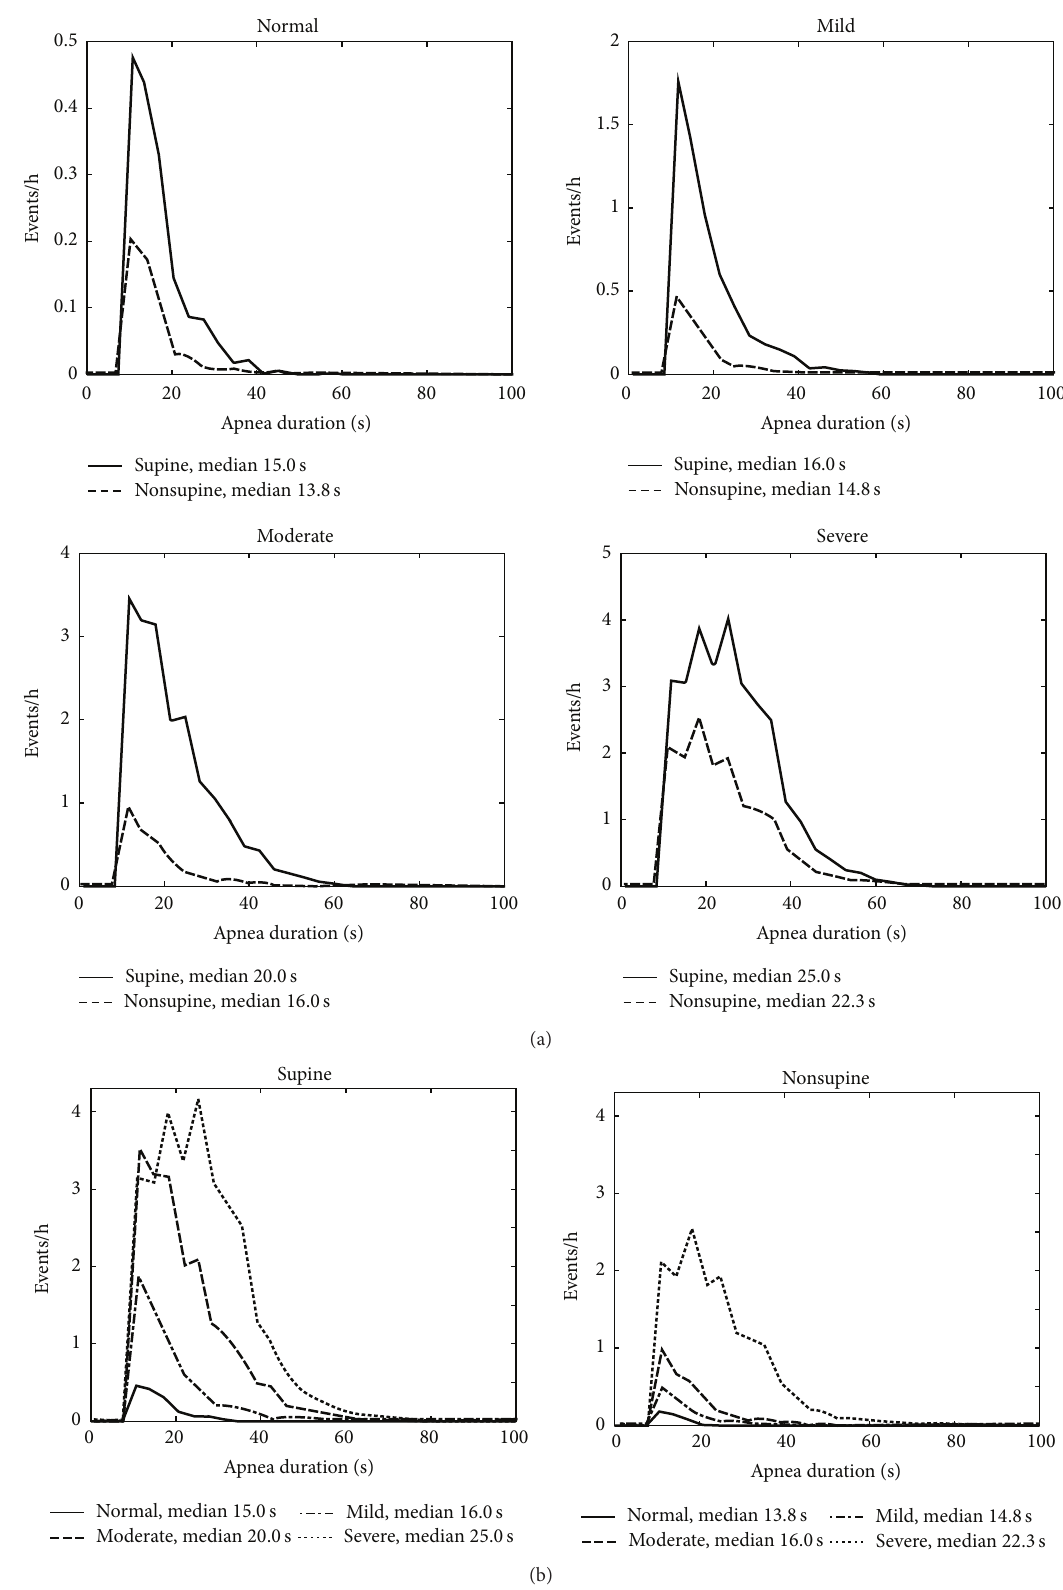
Figure 1: (a) Positional sleeping time adjusted distributions of the durations of individual apnea events in supine and nonsupine positions in different OSA severity categories and (b) distributions in nonsupine and supine positions as a function of OSA severity. In all OSA severity categories the apnea events are longer in supine position than in the nonsupine position. Based on mixed model analysis, the differences are statistically significant in all OSA severity categories. Also the median durations of apnea events increase along increasing OSA severity in both supine and nonsupine